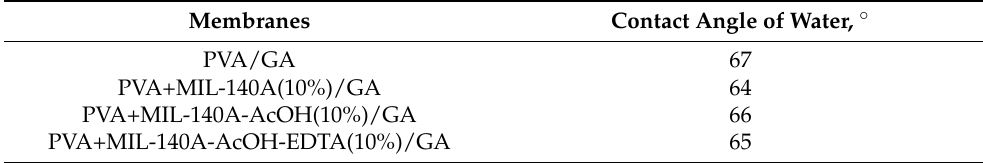
Table 4. The contact angle of water for the cross-linked PVA and PVA/Zr-MOFs(10%) membranes. Membranes Contact Angle of Water, ◦